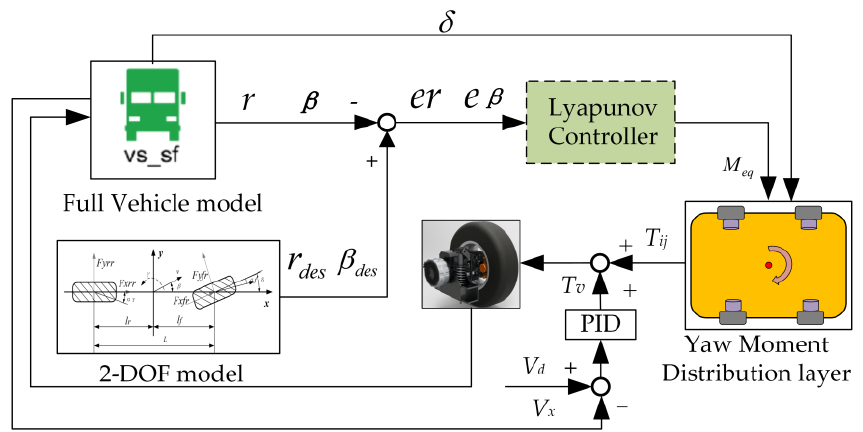
Figure 3. The yaw stability control structure.